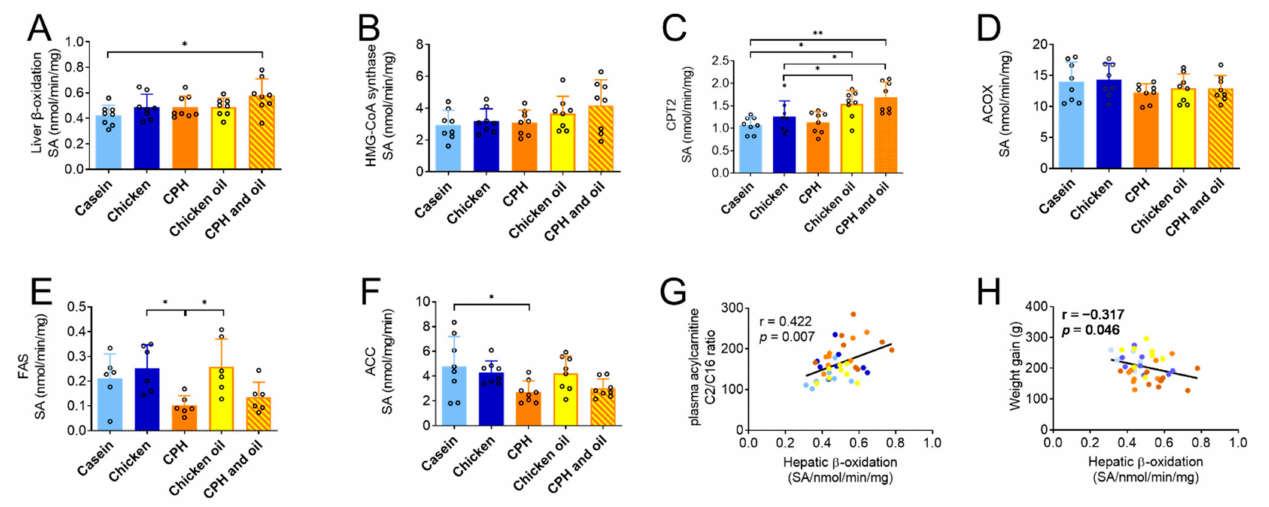
Figure 6. Hepatic enzyme activity in Wistar rats fed high-fat diets with casein, chicken protein (meat), chicken protein hydrolysate (CPH), chicken oil, or a combination of CPH and chicken oil for 12 weeks. ( A ) β -oxidation with or without malonyl CoA was analyzed in fresh samples, while the activity of ( B ) carnitine palmitoyltransferase II (CPT2), ( C ) HMG-CoA-Synthase, ( D ) peroxisomal acyl-conezyme A oxidase 1 (ACOX1), ( E ) fatty acid synthase (FAS), ( F ) acetyl-CoA carboxylase (ACC) was measured in frozen liver homogenates. Means values with standard deviation are given, and individual values are indicated by circles ( n = 6–8). One-way ANOVA with Tukey’s multiple comparisons test between all diet groups was performed (* p < 0.05, ** p < 0.01). Pearson correlation coefficient (two-way) was calculated between the acetylcarnitine (AC2)/palmitoylcarnitine (AC16) ratio and hepatic β -oxidation ( G ), and between rat weight gain and hepatic β -oxidation ( H ). Light blue is control, dark blue is chicken protein, orange is CPH, yellow is chicken oil, and dark orange is CPH and chicken oil ( G , H